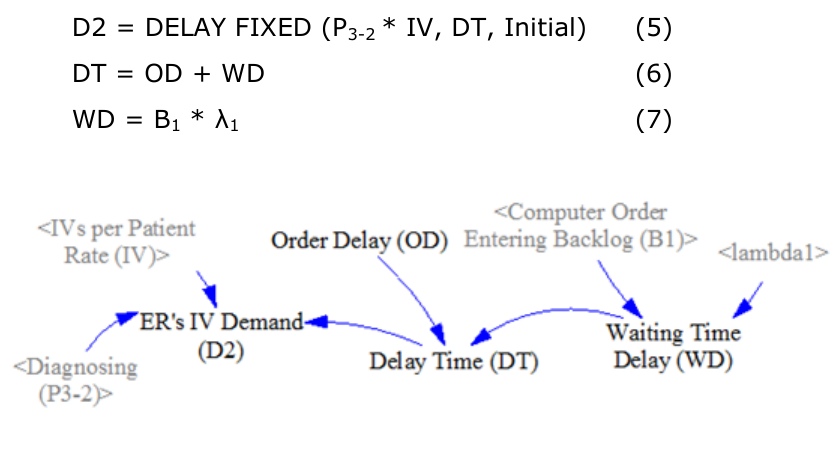
Figure 3. A Sub-model linking the pharmacy and ER